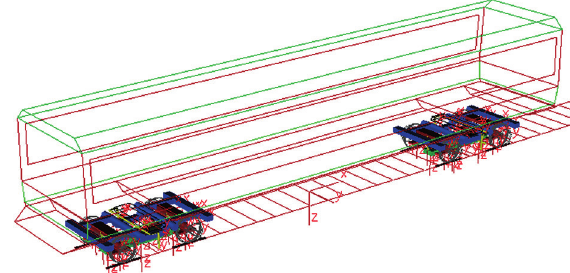
Fig. 3. The linear metro vehicle